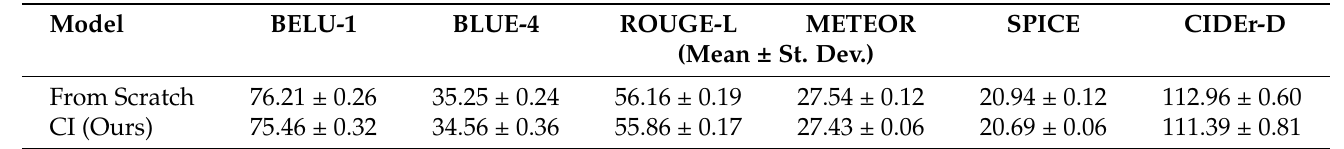
Table 9. Comparison of metric scores of ORT structure two models, From Scratch and CI. Training seven times for each